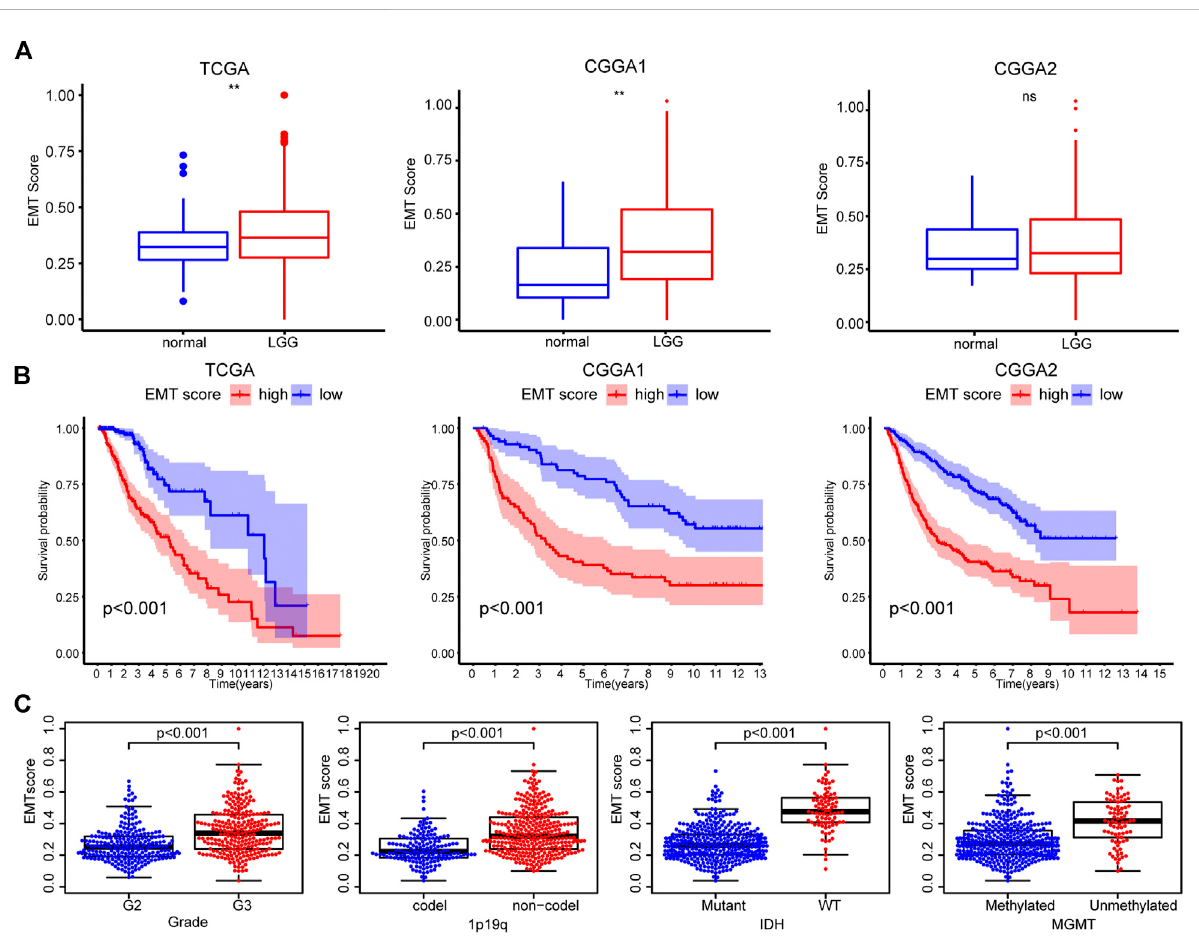
FIGURE 2 (A) Differences inEMTscores between nontumor tissues and LGG based on theTCGA, CGGA1,and CGGA2datasets (B) K-Mcurvesofthe